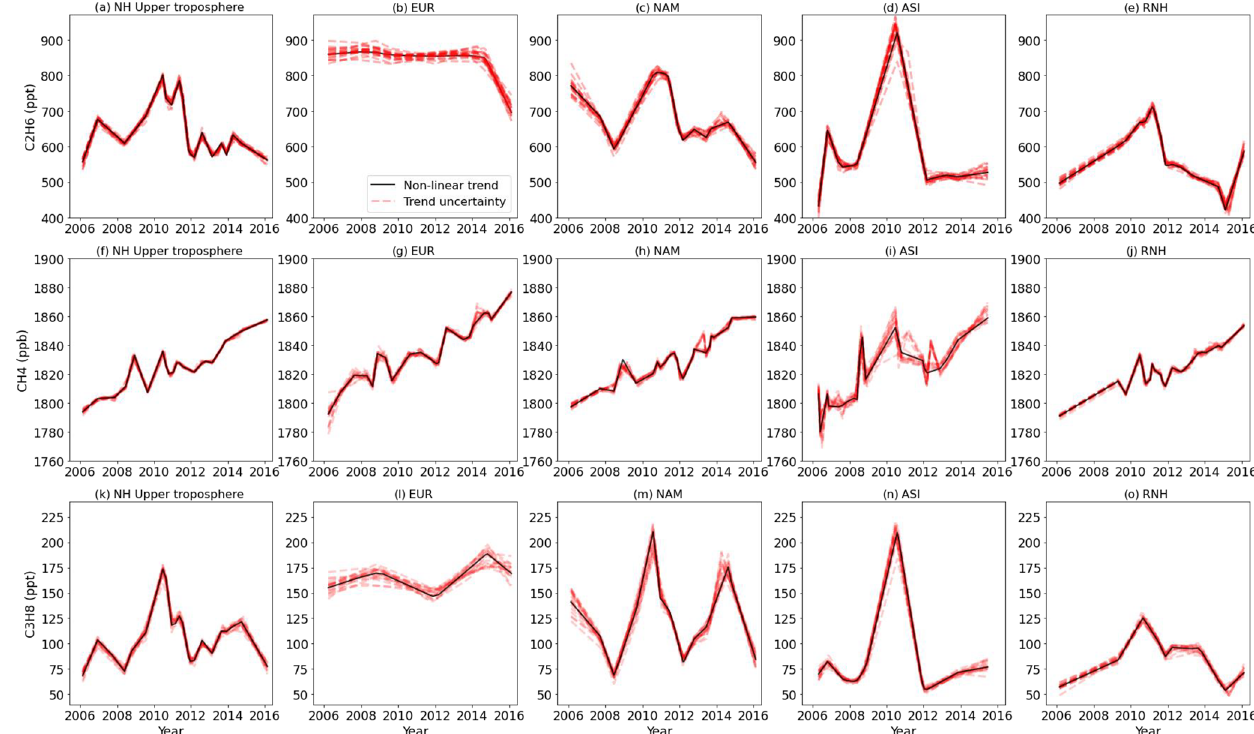
Figure 3. Nonlinear trends of the upper tropospheric ethane, methane and propane over five regions (whole NH upper troposphere, EUR, NAM, ASI, and